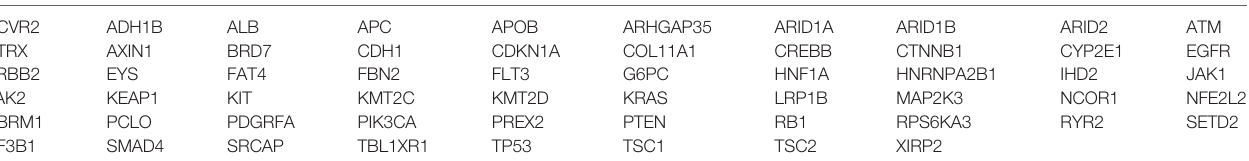
TABLE 1 | Cancer genes for targeted sequencing.